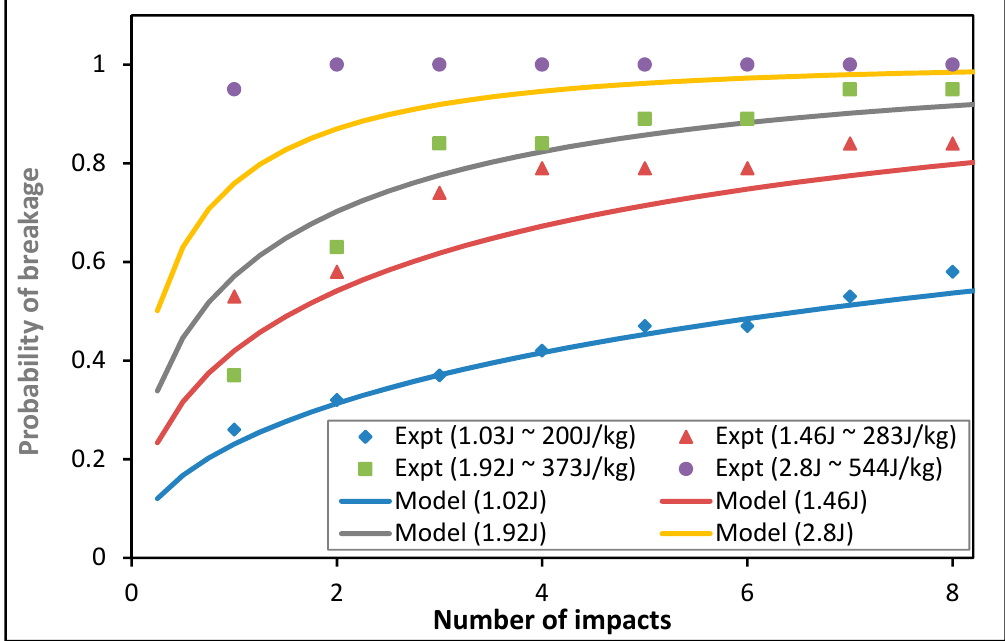
Figure 10. Experimental and Model Breakage probability curves for a − 16 mm + 13.2 mm Gold waste rock sample.